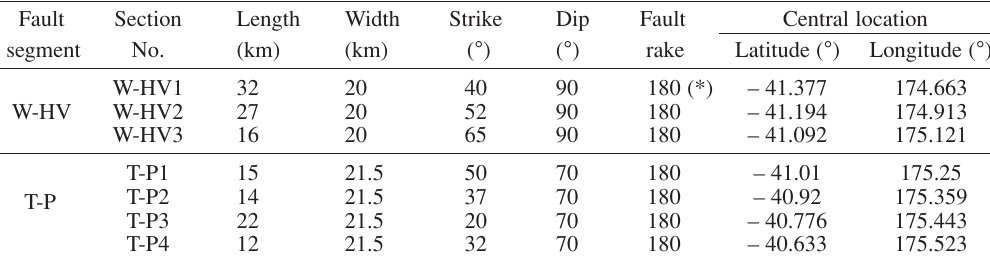
Table III. Parameters about W-HV segment and T-P segment of the Wellington Fault for calculating (cid:54) CFS (modified from Berryman and Van Dissen, 2001, and personal communication with Russ J. Van Dissen). Fault Section Length Width Strike Dip Fault Central location segment